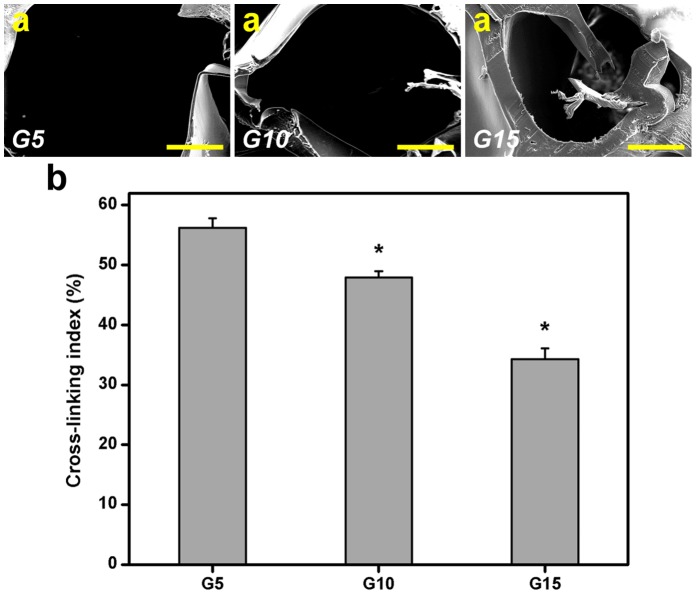
Morphological observations and cross-linking analyses.(a) Representative scanning electron microscopic images of various gelatin discs after cross-linking. Scale bars: 100 µm. (b) Cross-linking index of various gelatin discs. An asterisk indicates statistically significant differences (*P<0.05; n = 5) as compared with the G5 groups.